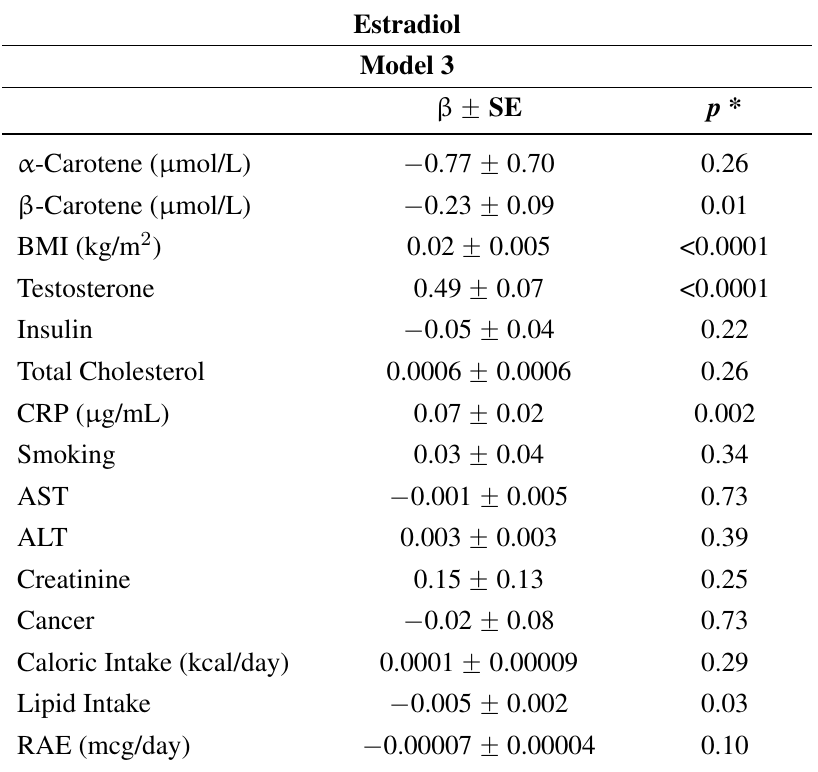
Table 3. Multivariate model addressing the relationship between α -Carotene and β -Carotene and